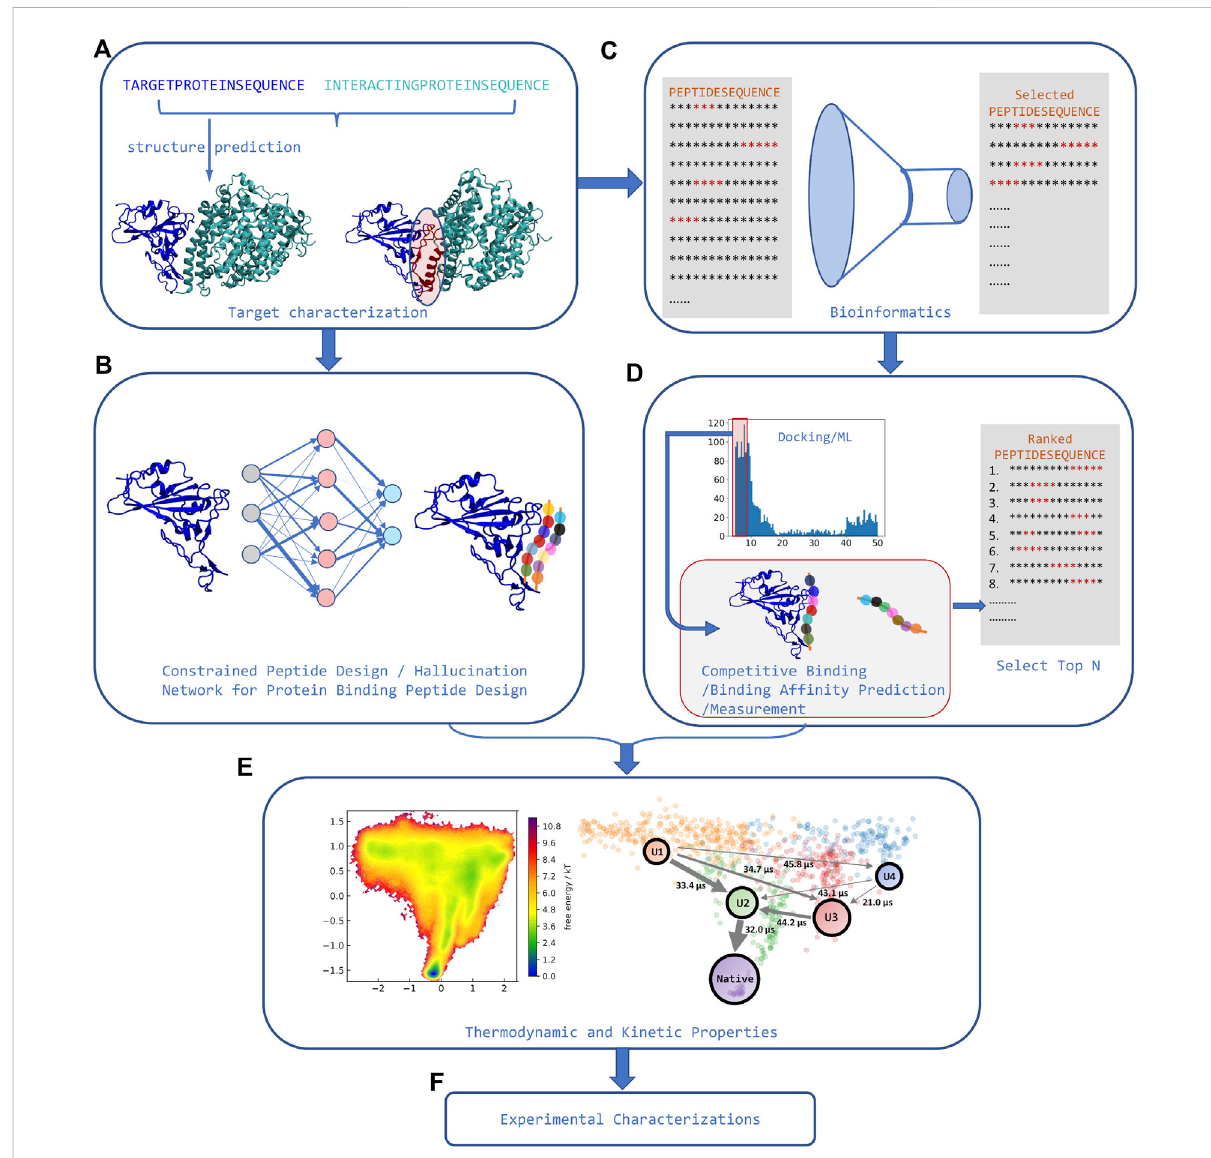
FIGURE 2 Strategies for rational peptide design. (A) . The structure of target protein and its interacting partners is fi rst identi fi ed, and interface features are extracted from the complex. (B) Machine learning models can use these interface features to perform constrained peptide design for that target. (C) Alternatively, using these interface features, bioinformatics tools can signi fi cantly narrow down the sequence search space. (D) Peptide docking tools or AI tools can then be used to predict binding in the now reduced set of candidate sequences. Competitive binding study or high throughput binding af fi nity measurement can rank order the selected sequences from the docking step. (E) In some cases, orthogonal modeling capable of predicting kinetic and/or thermodynamic properties can further narrow down the number of possible sequences selected for experimental determination (adapted from (Chang and Perez, 2022b)). (F) Finally, experimental characterization and validation can be carried out for the now manageable number of predicted peptide